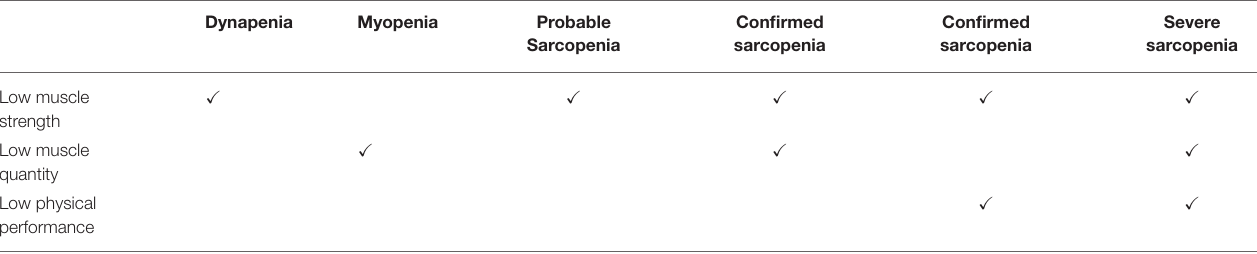
TABLE 1 | Diagnostic criteria for